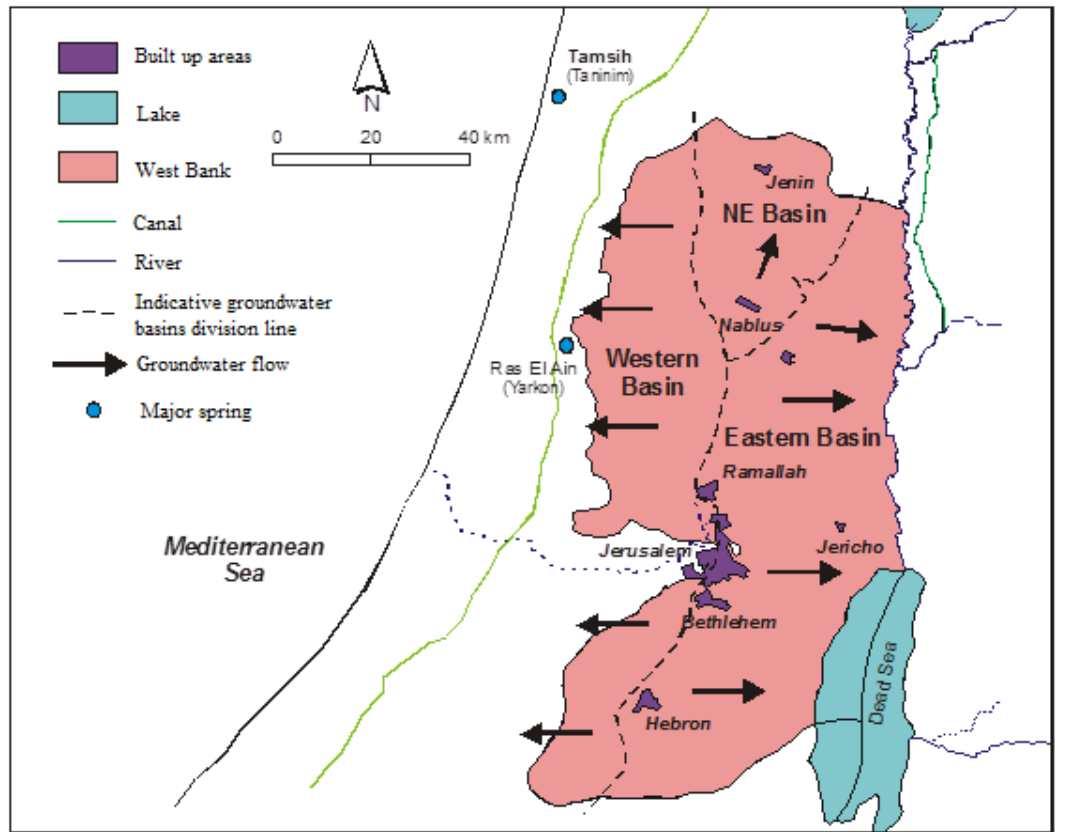
Figure 1. Groundwater basins in the West Bank of Palestine .